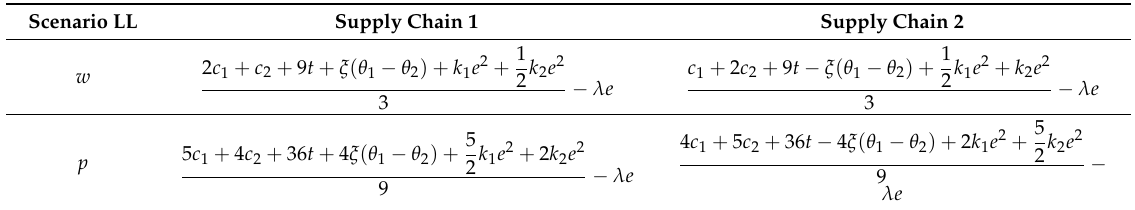
Table 5. Equilibrium outcomes with subsidy under scenario